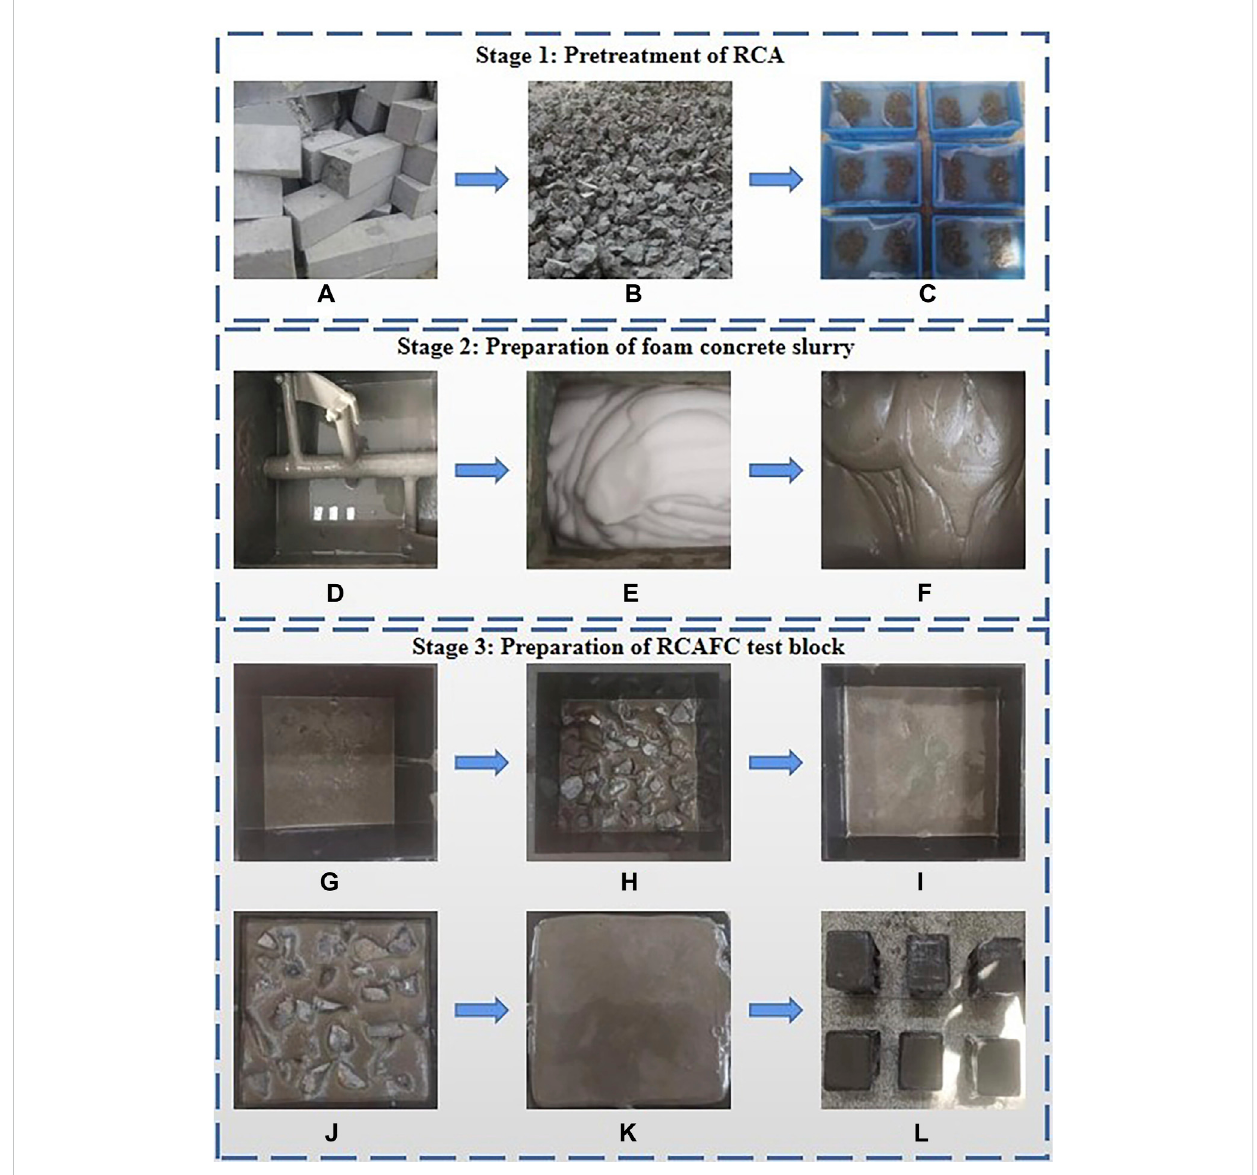
FIGURE 3 Three stages of on-site test block pouring: (A) Laboratory waste concrete; (B) Arti fi cial crushing; (C) Soaking treatment of RCA; (D) Cement paste after mixing; (E) Add foam; (F) Foam concrete paste after mixing; (G) Grout pouring; (H) First dumping and fi lling of RCA; (I) Continue to pour grout; (J) Second dumping and fi lling of RCA; (K) Completion of pouring; (L)